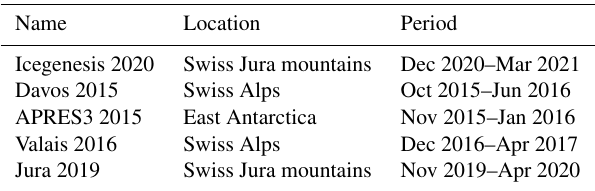
Table 3. List of field installations of the MASC instrument, for which data are shown in Figs. 6 and